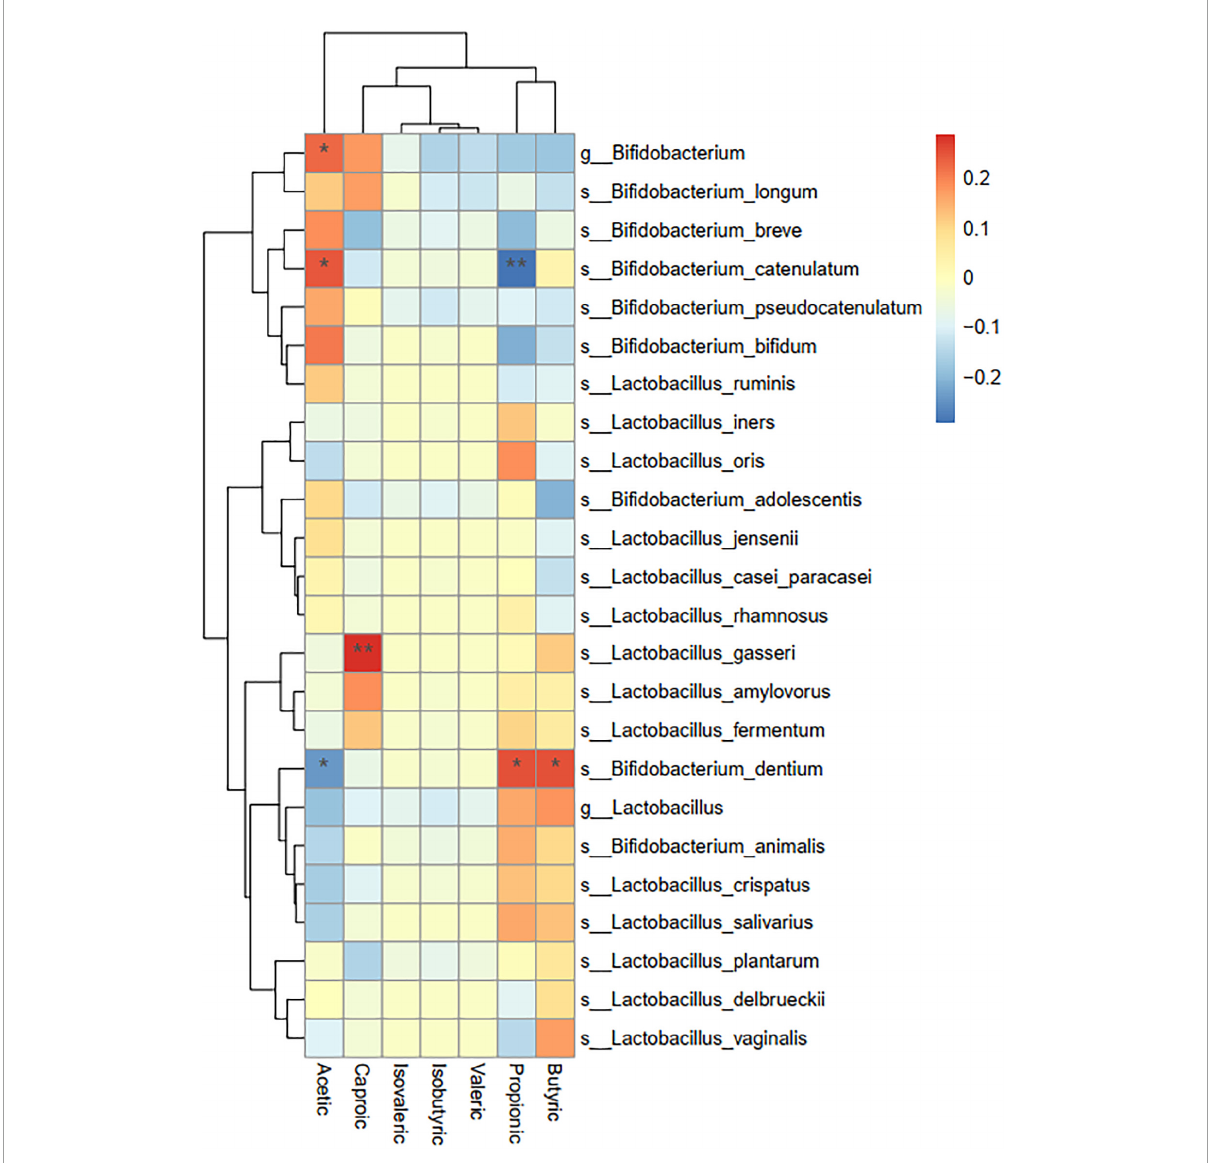
FIGURE4 Correlation analysis between probiotics and short-chain fatty acids. Asterisks represent that the corresponding probiotics have a significant correlation with short-chain fatty acids. Red means positive correlation, and blue means negative